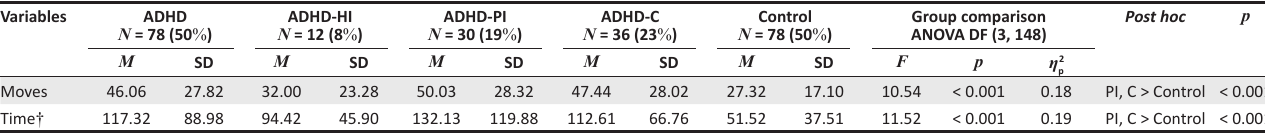
TABLE 2: Analysis of variance: Number of moves and time taken for the Tower of London. Variables